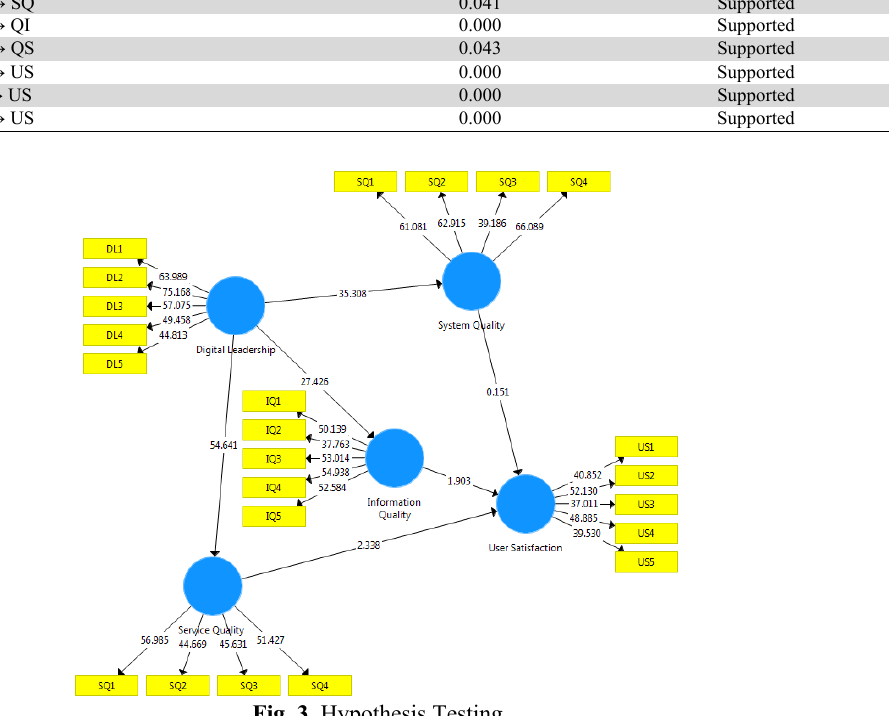
The results of hypothesis testing Correlation